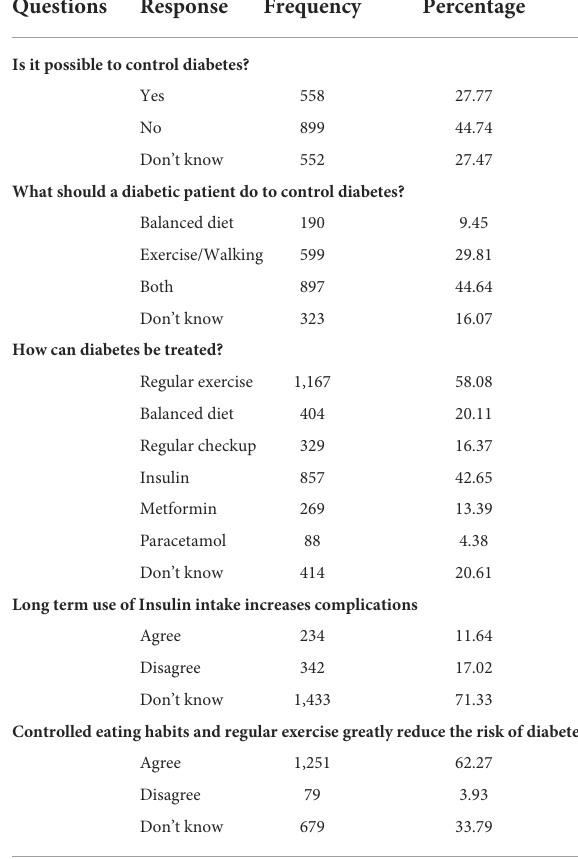
TABLE 3 Frequency distribution of the responses to attitude